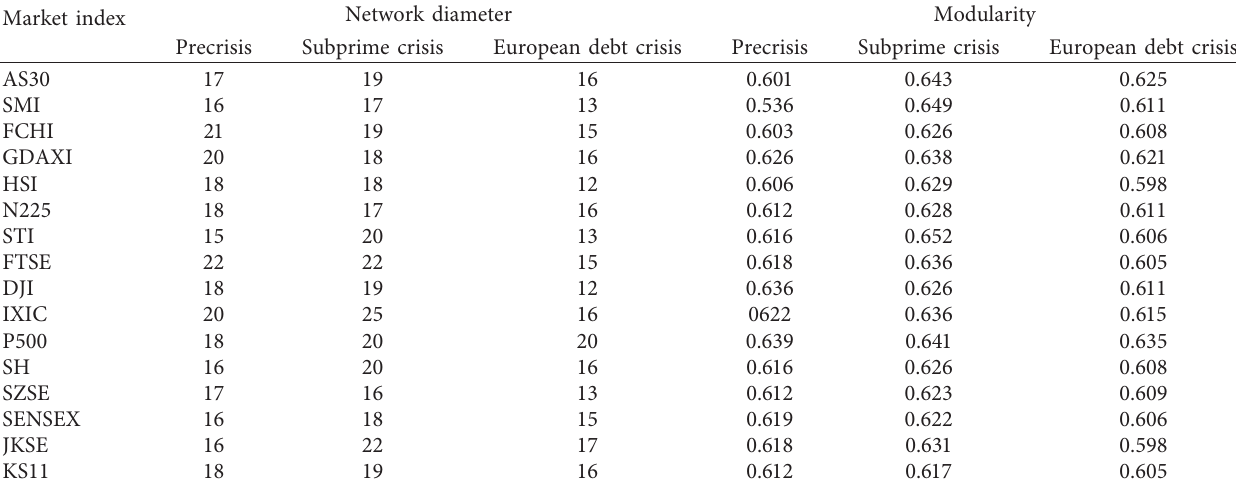
Table 2: EMD distance statistics data of each market